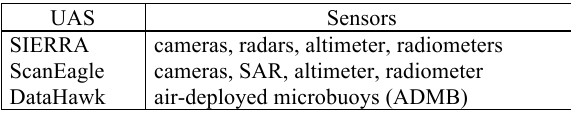
Table 3. Sensors carried on the MIZOPEX platforms